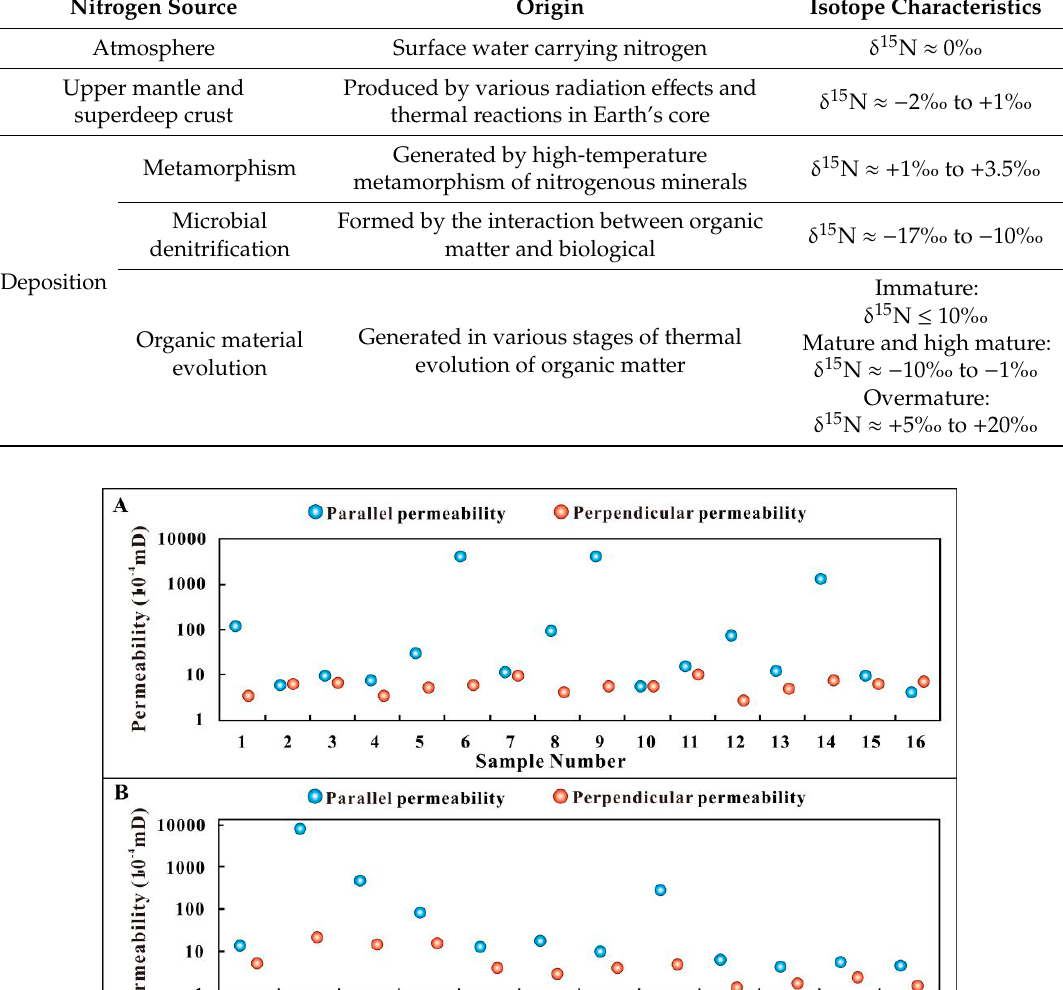
Table 3. Isotope variation characteristics of nitrogen from various sources (Zeng, 2002 and Liu et al., 2006).